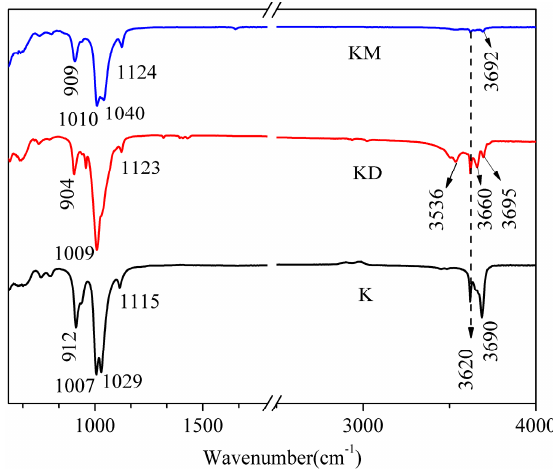
Figure 5. FTIR spectra of K, K-D, and K-M.